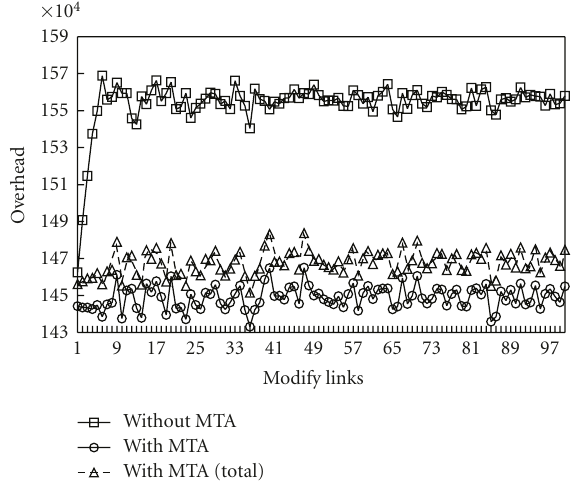
Figure 6: The Average Adaptation Cost using MTA Procedure (1– 100 links).